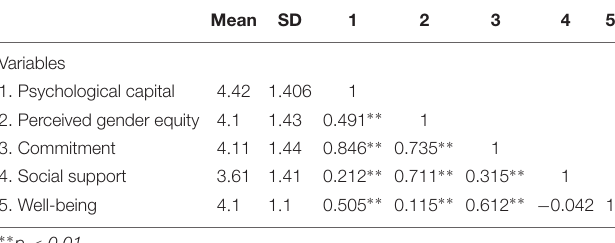
TABLE 1B | Means, standard deviations, and inter correlations among study variables (Women). Mean SD